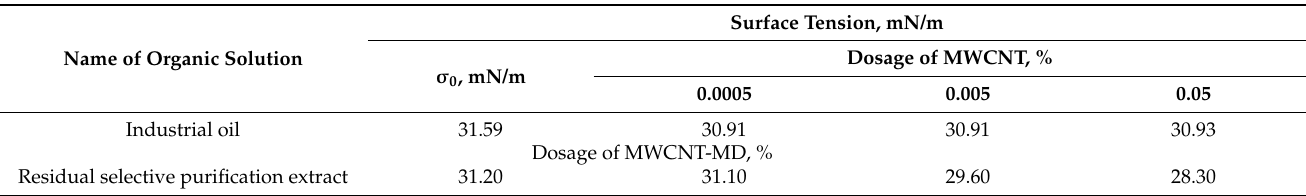
Table 5. Dependence of surface tension on the concentration of MWCNT and